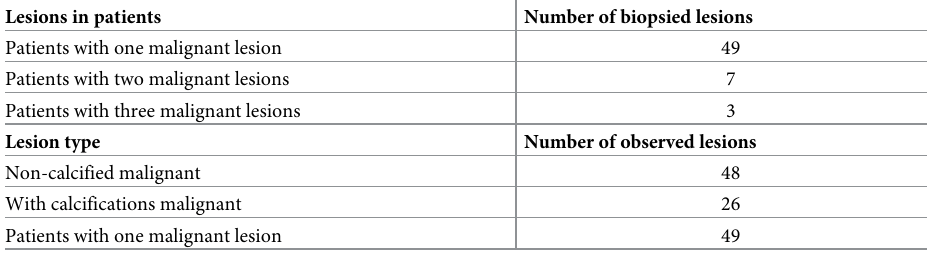
Table 2. Details of lesion cases of group C (malignant) included in the observers study.